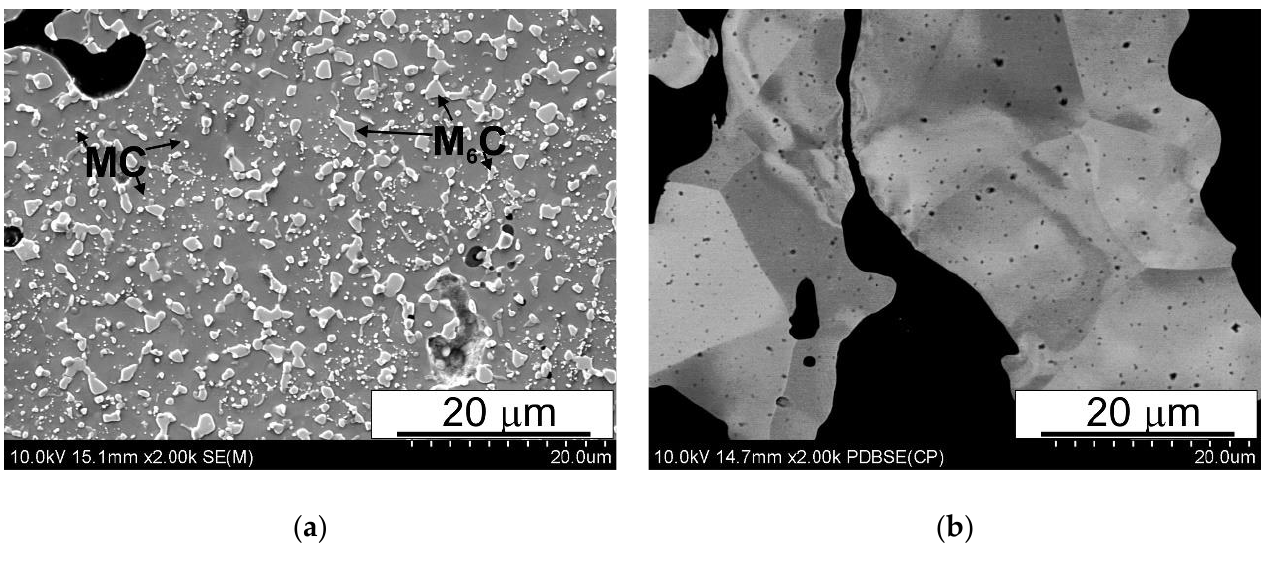
Figure 2. Powder microstructures: ( a ) T15 HSS, ( b ) Fe; SEM. The powder mixtures were sintered at temperatures of 950, 1000 and 1050 ◦ C and at rate was 100 ◦ C/min and the pulsed current on:off ratio was set at 125:5 (in ms). Samples with dimensions of Ø40 × 10 mm were produced.